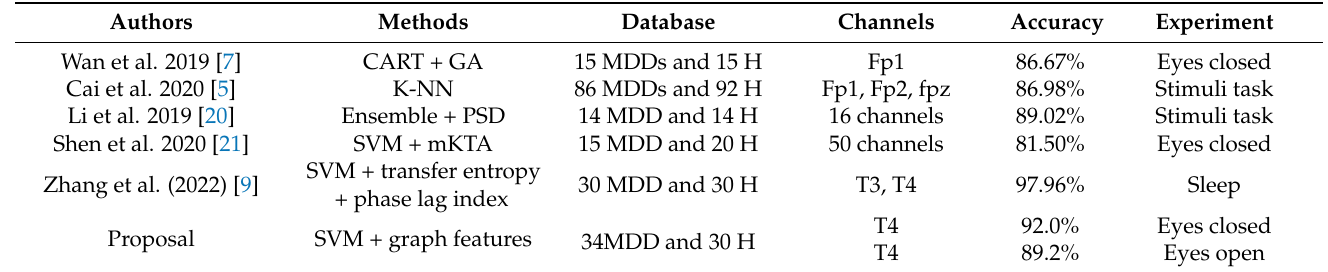
Table 4. Comparing existing methods with the proposed method for depression